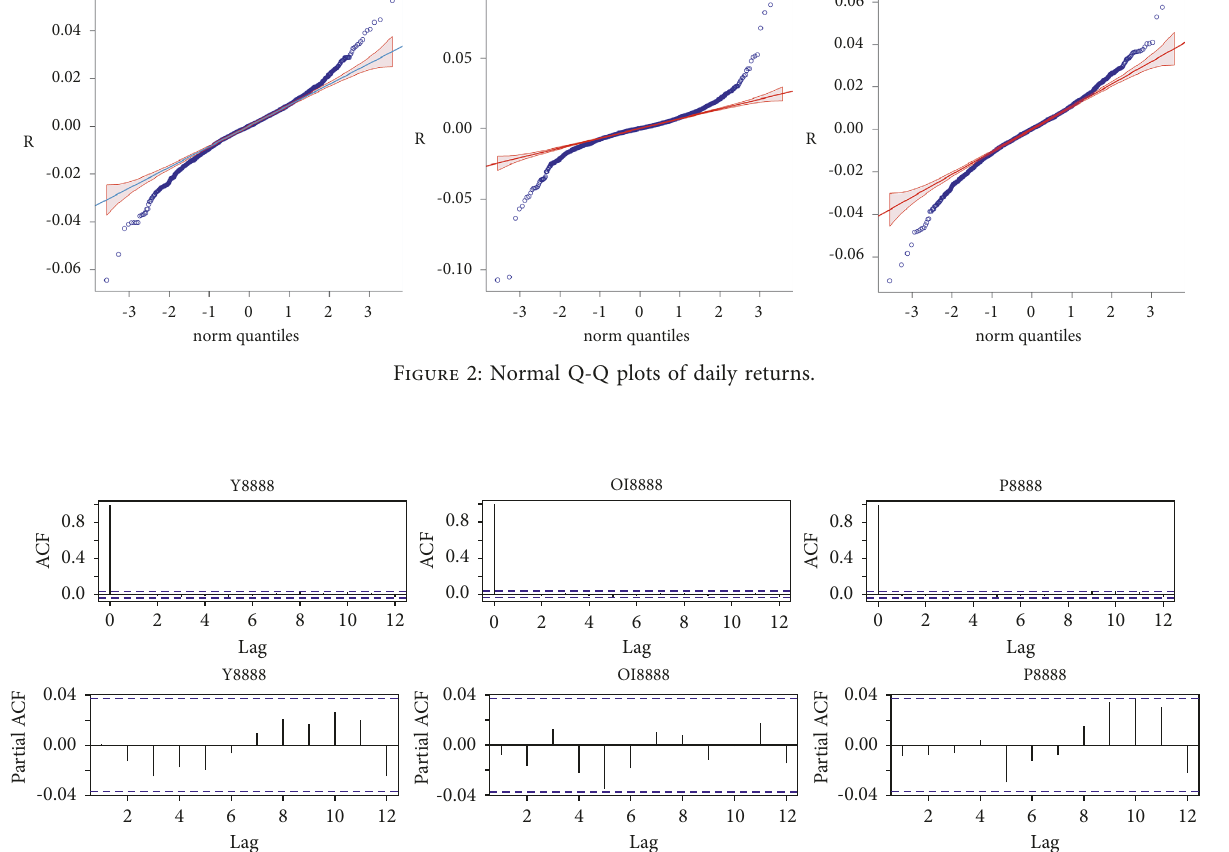
Figure 3: Autocorrelation and partial autocorrelation of daily